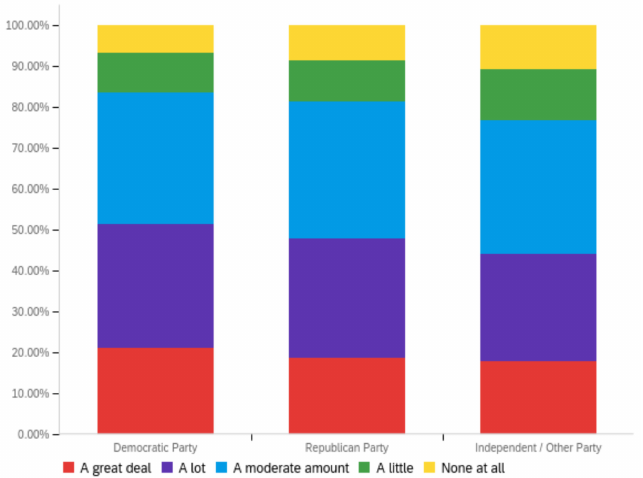
Figure 10. Article controversy level—others’ perception impact by political affiliation.